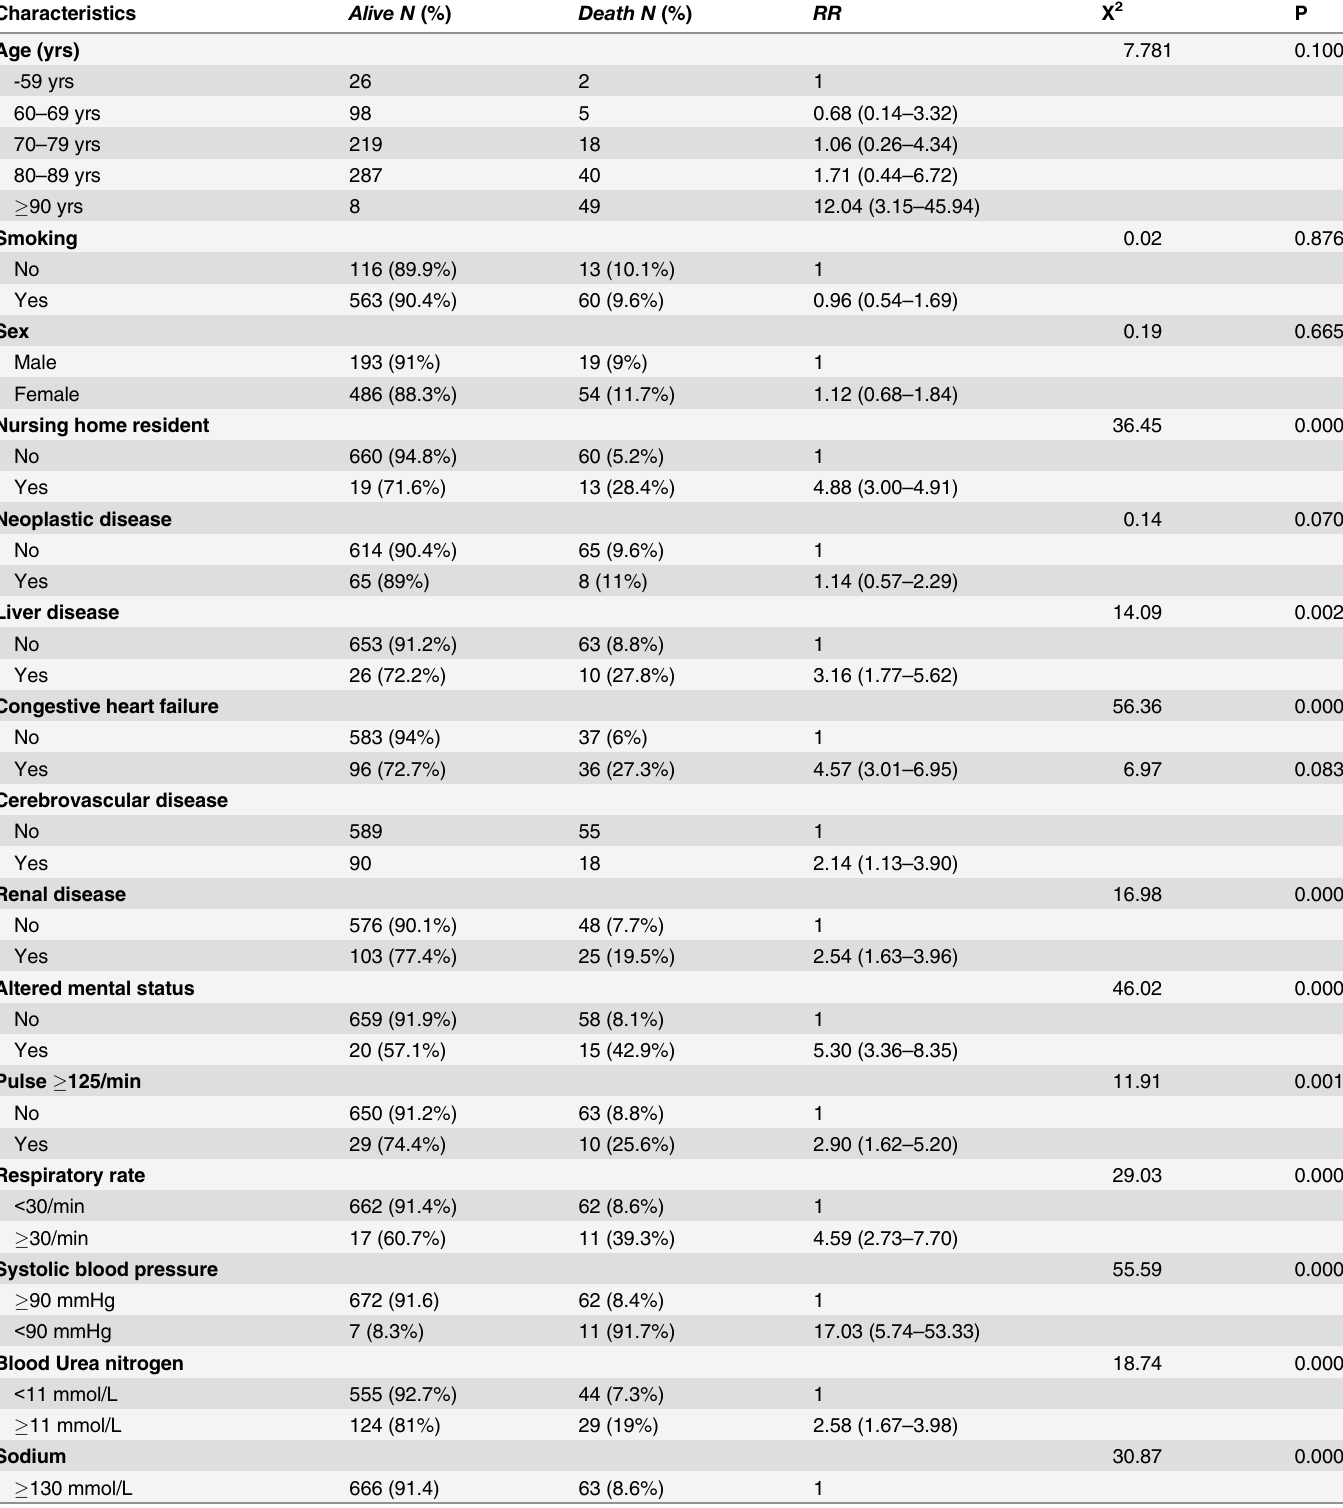
Table 2. Mortality Risk in Patients with